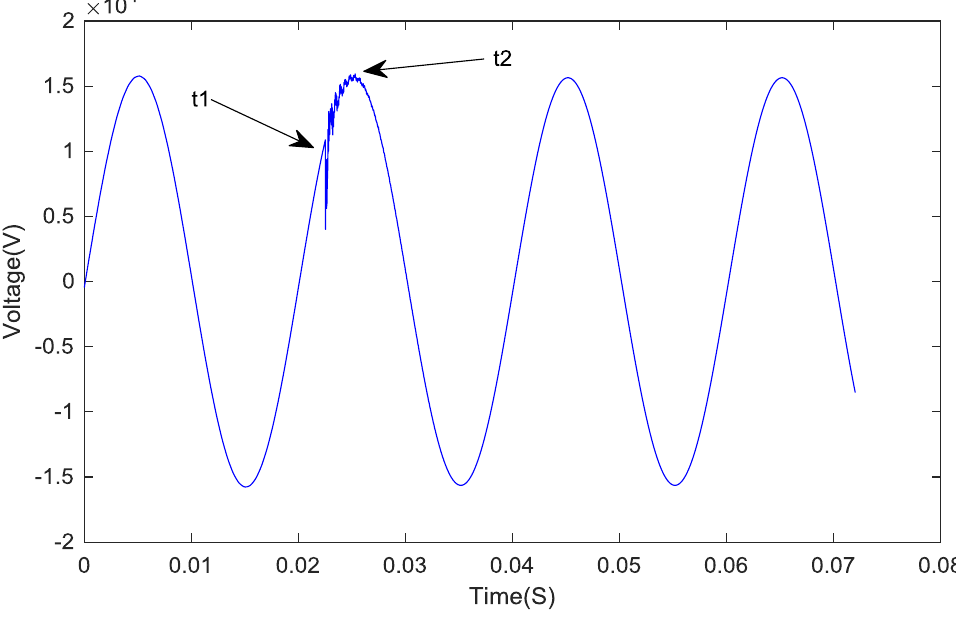
Figure 7. Voltage waveform of phase a , when a fault occurs.